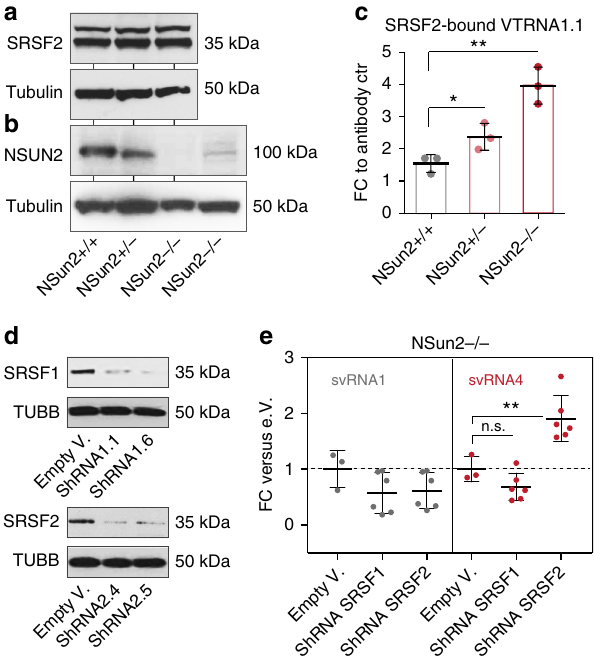
Fig. 3 Methylation-guided VT-RNA1.1 processing is altered in the absence of SRSF2. a , b Western blot for endogenous SRSF2 ( a ) and NSUN2 ( b ) in NSUN2- expressing ( + / + , + / − ) and -lacking ( − / − ) human fi broblasts (from two patients). Tubulin served as a loading control. c qRT-PCR measuring SRSF2- bound VTRNA1.1 normalised to the control (ctr; Rabbit serum conjugated with Dynabeads) after recovering the pulled down RNA in the SRSF2 immunoprecipitation. d Western blot for SRSF1 and SRSF2 in NSUN2 − / − human fi broblasts infected with shRNAs (1.1, 1.6, 2.4, 2.5). Tubulin served as a loading control. e Fold-change (FC) of svRNA1 and 4 abundances after knock- down of SRSF1 and 2, relative to NSUN2 − / − cells infected with the empty vector (e.V.). Shown are the pooled values using the two shRNA constructs shown in ( d ). Error bars indicate s.d. ( n = 3-6 qRT-PCRs). ** p <0.01 students t -test. Source data are provided as a Source Data fi